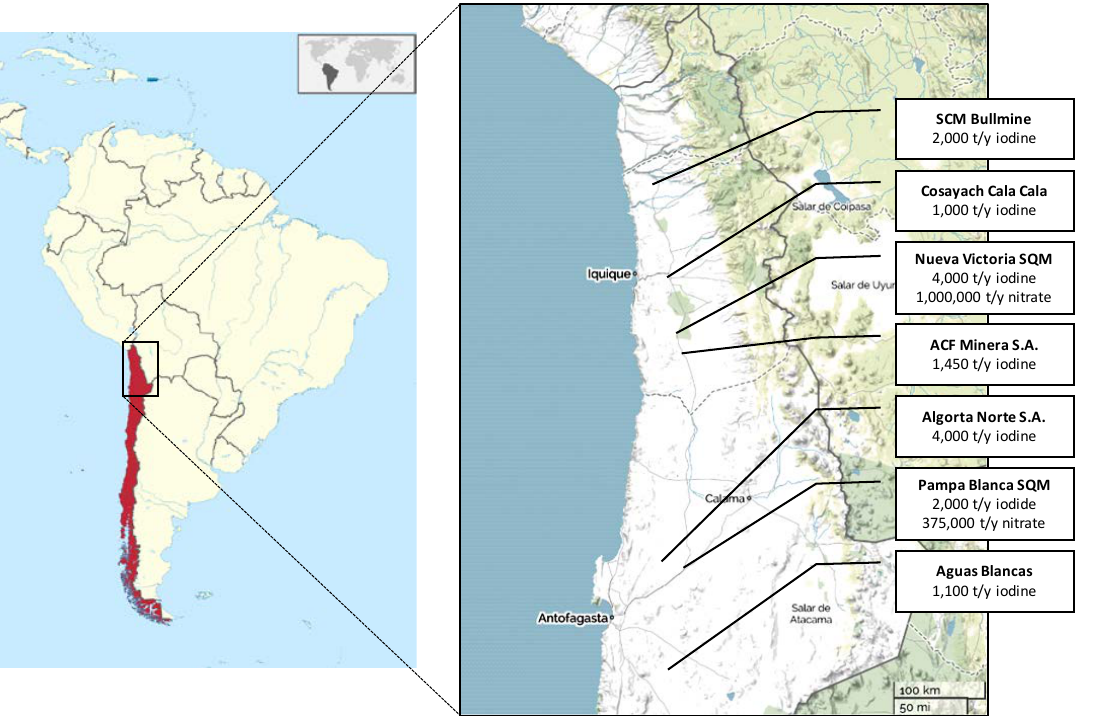
Figure 1. Chilean operations of caliche exploitation in Northern Chile and their annual production.